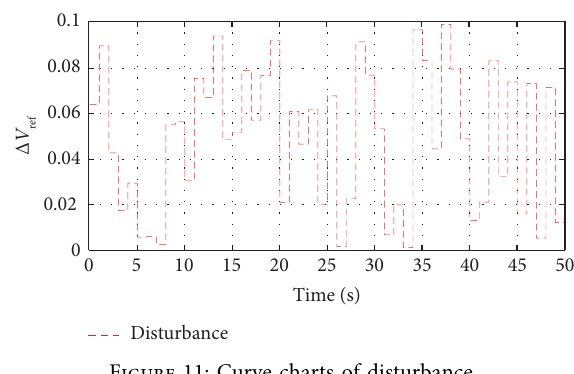
Figure 11: Curve charts of disturbance.